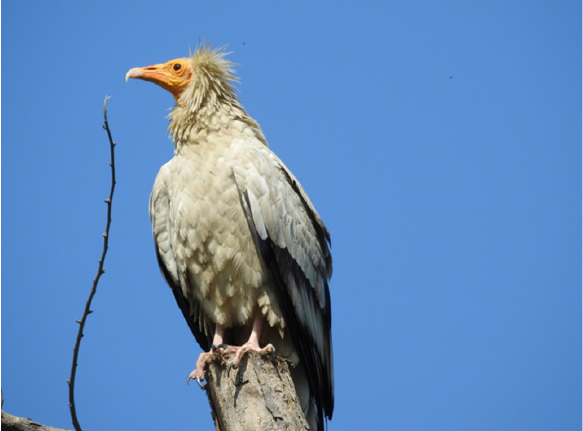
Figure 10. A cliff nesting, Endangered, resident, Egyptian Vulture Neophron percnopterous perched on a hacked drying